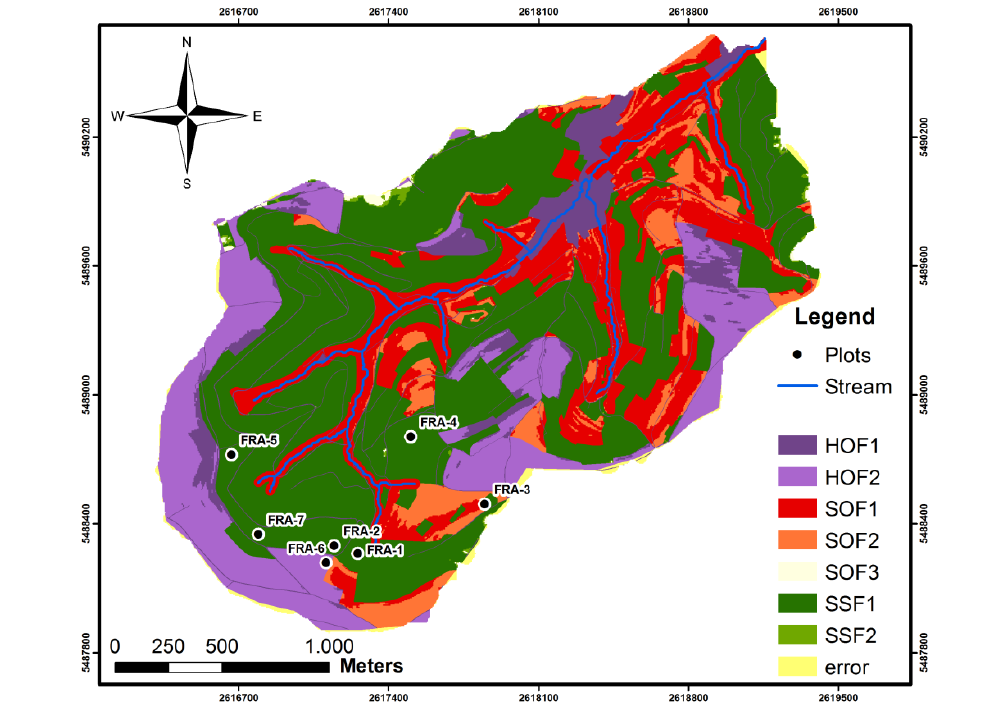
Figure 11. GIS-DRP map Frankelbach extreme event (error = lack in basic